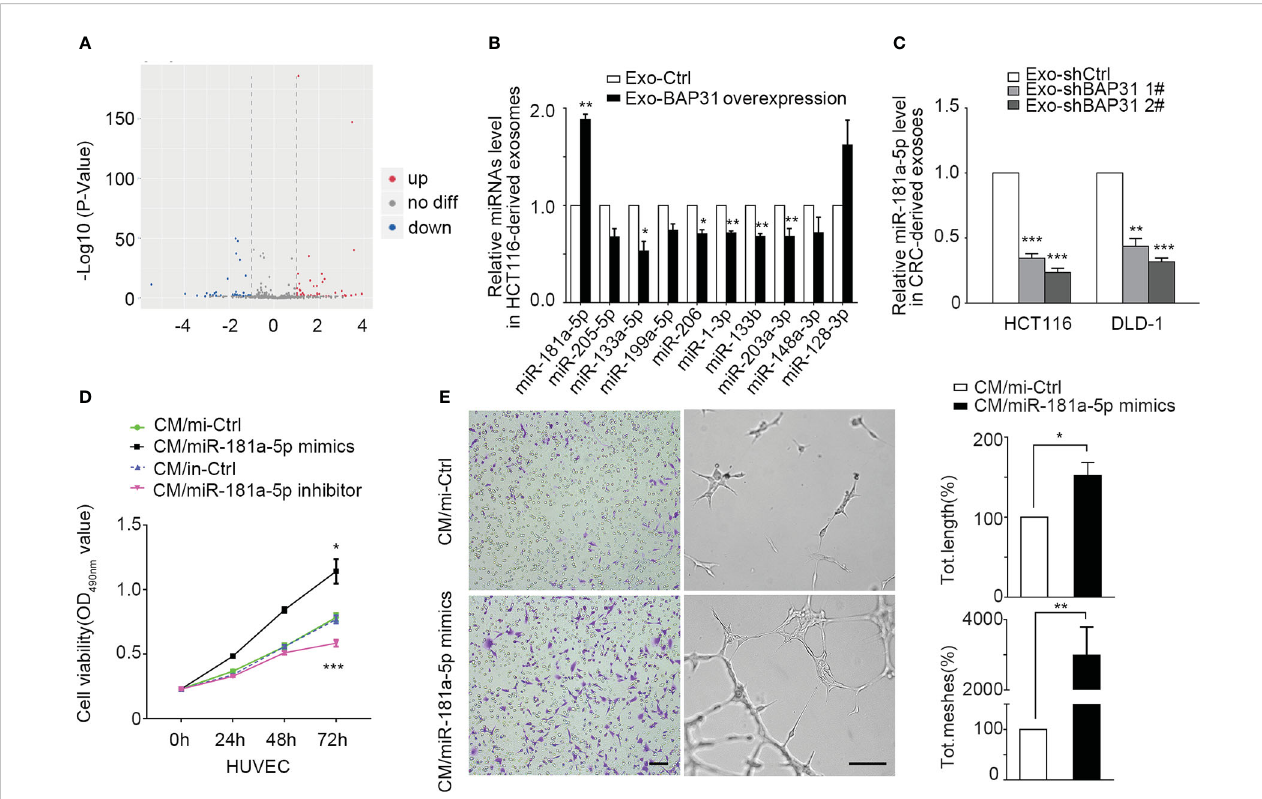
FIGURE 3 Exosomal miR-181a-5p was positively regulated by the expression of BAP31. (A) Heatmap of microarray data shows the differences of exosomal miRNAs from BAP31-overexpressing CRCs. (B) qPCR analysis shows the expression of exosomal miRNAs from BAP31-overexpressing CRCs. Mean ± SEM are provided (n = 3). * p < 0.05 and ** p < 0.01. (C) qPCR analysis shows the expression of exosomal miR-181a-5p from BAP31-knockdown CRCs. Mean ± SEM are provided (n = 3). *** p < 0.001. Fibroblasts were transfected with miR-181a-5p mimics to increase the miR-181a-5p expression of fi broblasts. The endothelial cells were treated by the conditioned medium from the fi broblasts. (D) MMT assay shows the endothelial cells proliferation. Mean ± SEM are provided (n = 3). * p < 0.05 and *** p < 0.001. (E) Transwell and tube formation assays show the endothelial cells migration and angiogenesis. Scale bar, 100 m m. Mean ± SEM are provided (n = 3). * p < 0.05 and ** p <